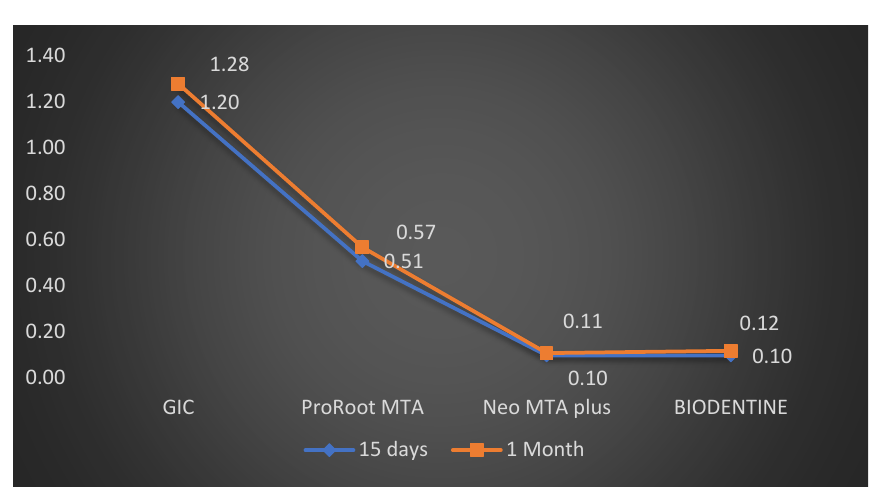
Figure 5. Comparison of sealing ability in all four groups between 15 days and one month.